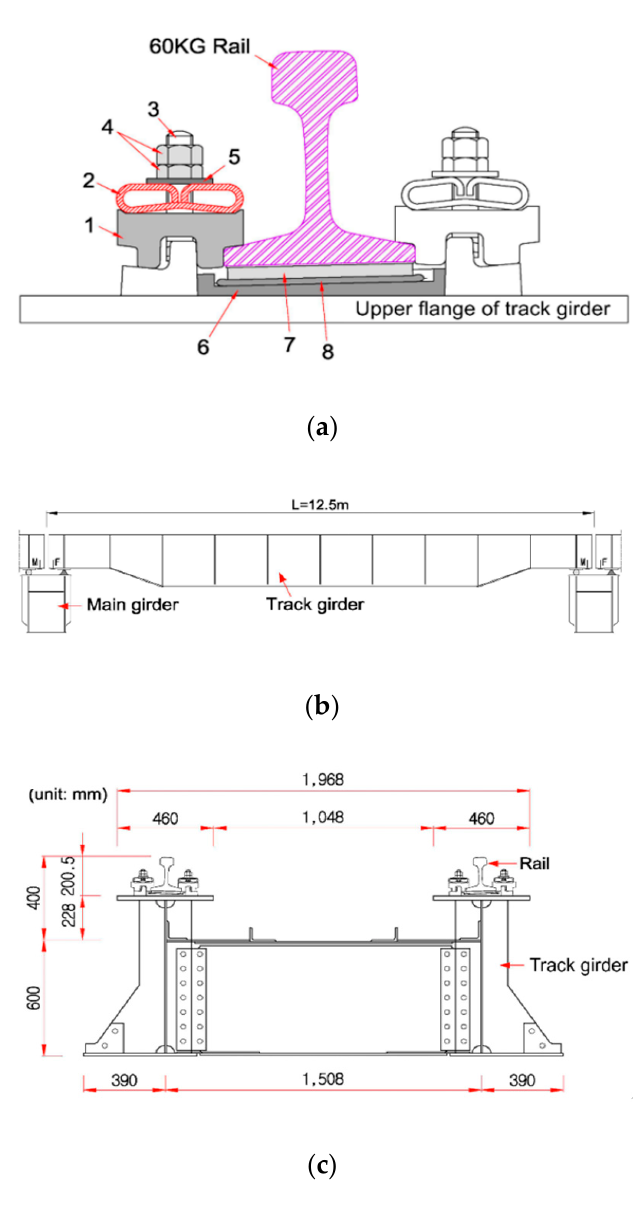
Figure 1. Schematics of the direct fixation track system. ( a ) Direct fixation rail fastening system 1. insulation block, 2. leaf spring, 3. bolt, 4. anti-loosening nut, 5. washer, 6. insulation plate, 7. rail pad, and 8. adjustable pad; ( b ) side view of the track girder; and ( c ) cross section of the track girder [2,3].